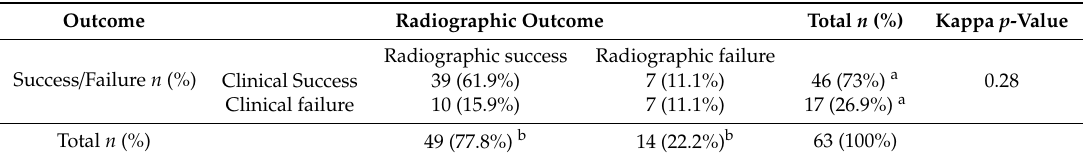
Table 3. Relationship between clinical outcome and radiographic outcome among successful and failed teeth at